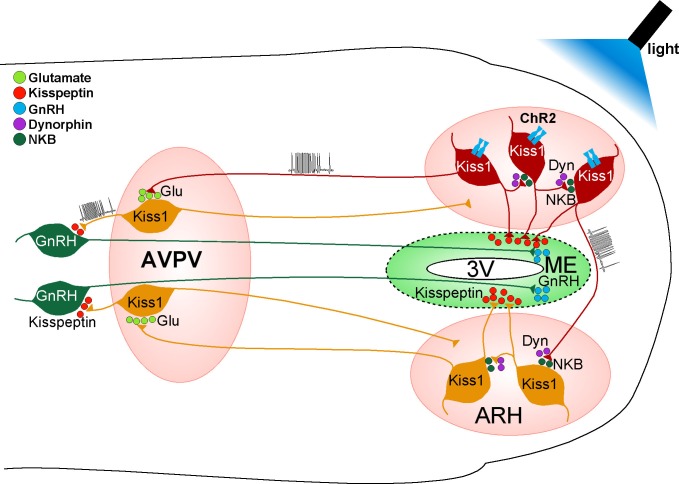
Proposed model by which activation of Kiss1 neurons governs GnRH neuronal excitability.High-frequency photostimulation of Kiss1 neurons in the ARH releases NKB that depolarizes and recruits other Kiss1ARH neurons. Dynorphin is co-released and acts presynaptically to modulate (inhibit) the release of NKB. Together the two peptides govern the synchronous activity of Kiss1ARH neurons and promote kisspeptin release that stimulates GnRH release in the median eminence (ME). Kiss1ARH neurons also communicate with the Kiss1AVPV/PeN neurons via the fast neurotransmitter glutamate, which stimulates burst-firing of Kiss1AVPV/PeN neurons. Activation of these rostral Kiss1 neurons releases kisspeptin to robustly excite GnRH neurons via activation of the GPR54 signaling cascade, thereby stimulating the release of GnRH at the time of the preovulatory surge. Kisspeptin, GPR54, NKB, Tacr3 and GnRH are all required for normal fertility.